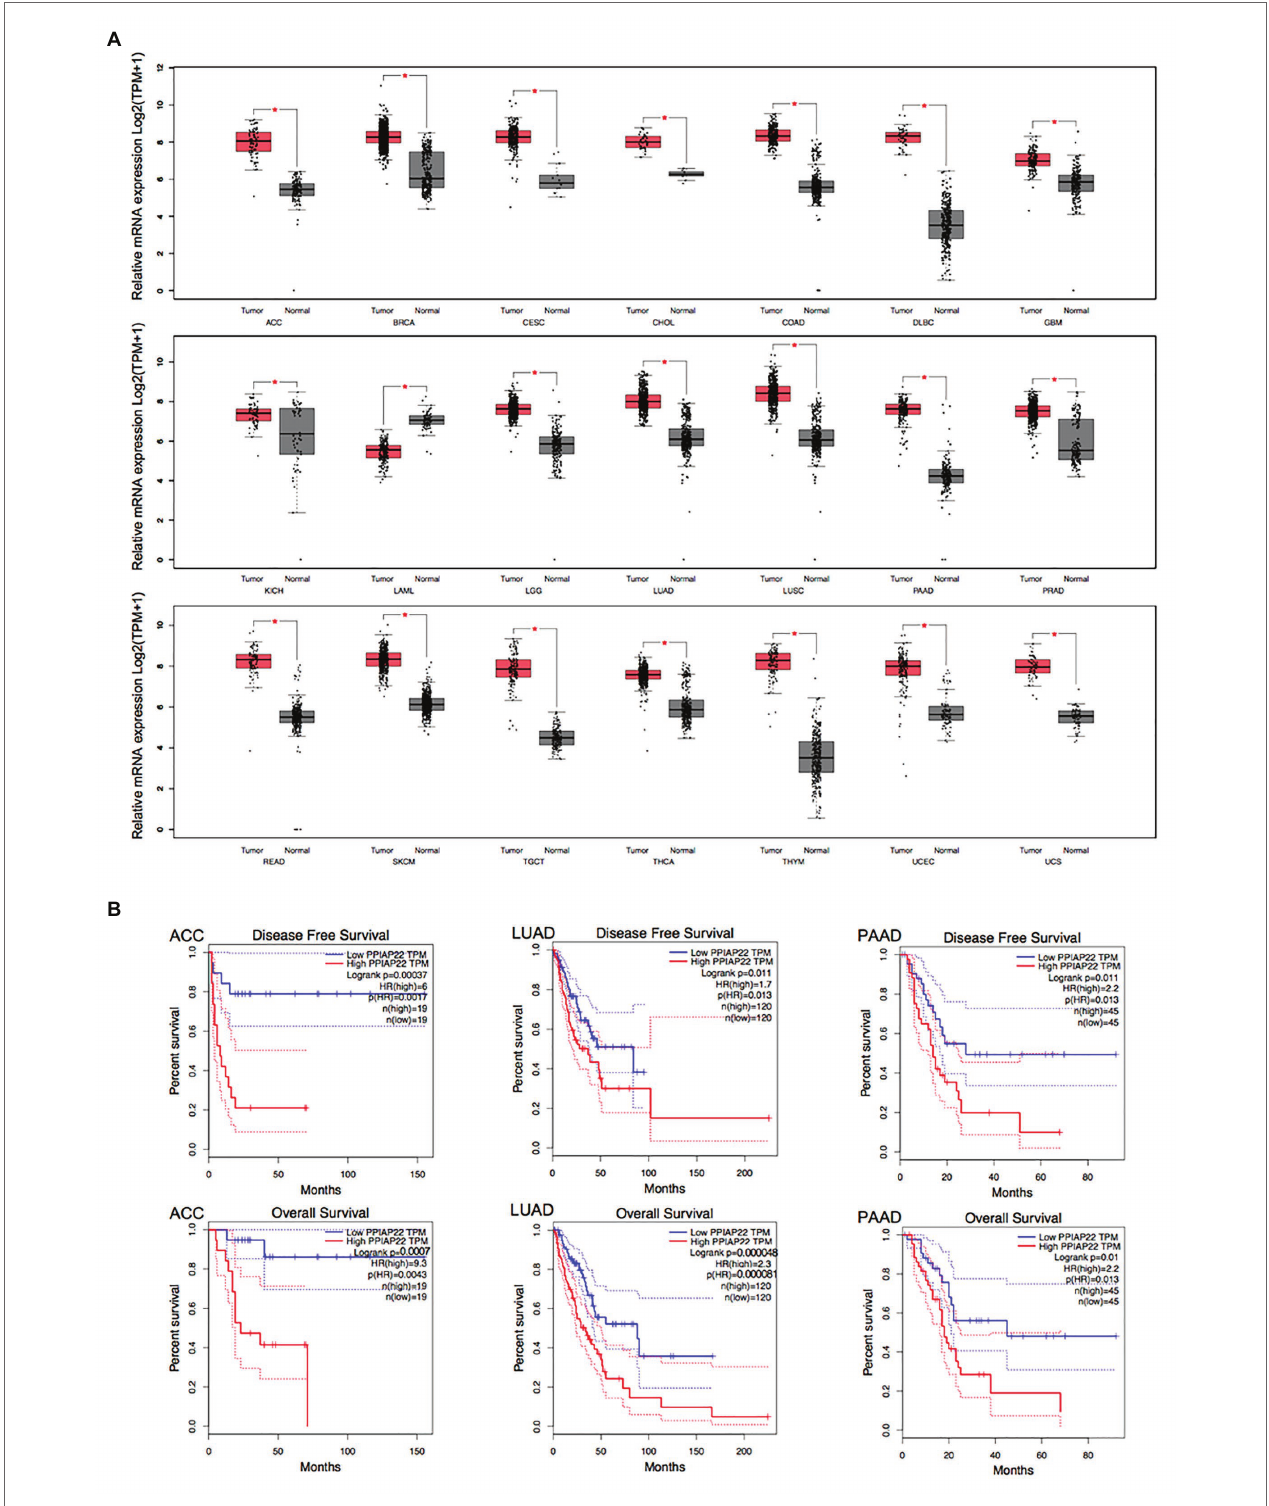
FIGURE 2 | Peptidylprolyl isomerase A pseudogene 22 plays a significant role in other types of cancer. (A) PPIAP22 was dysregulated in other types of cancer identified by using TCGA and GTEx databases through GEPIA. (B) Prognostic values of PPIAP22 in adrenocortical carcinoma (ACC), lung adenocarcinoma (LUAD), and pancreatic adenocarcinoma (PAAD) analyzed with GEPIA. The dotted lines represent the 95% CI. PPIAP22, peptidylprolyl isomerase A pseudogene 22; ACC, adrenocortical carcinoma; LUAD, lung adenocarcinoma; and PAAD, pancreatic adenocarcinoma. * p <